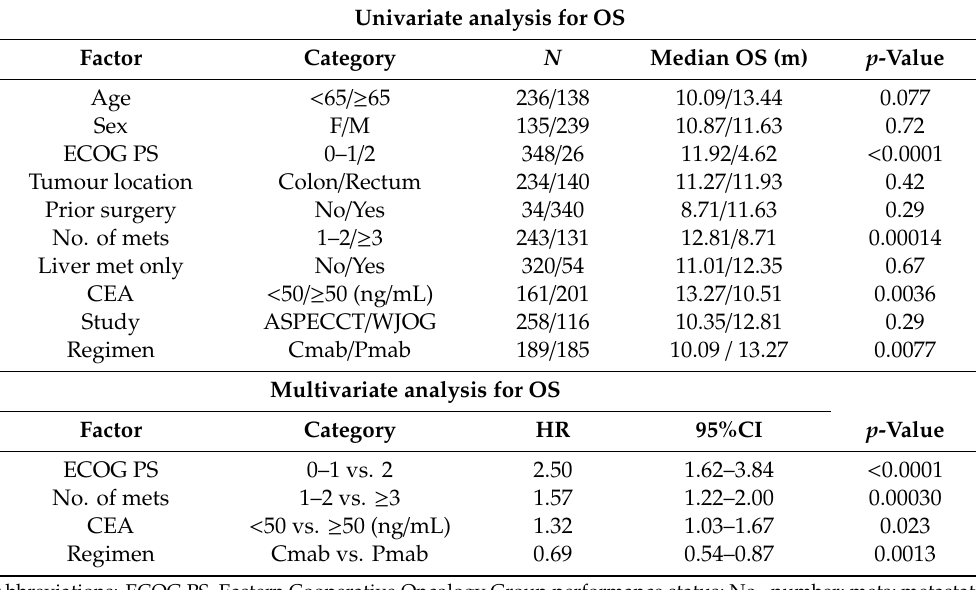
Table 2. Results of the univariate and multivariate analyses for OS.